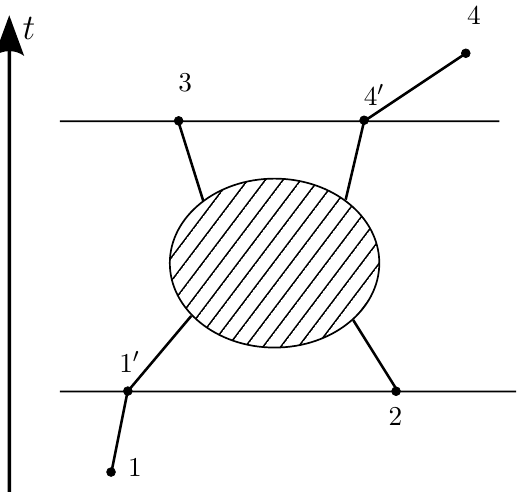
Figure 1 . Horizontal lines are t = t 3 and t = t 2 . The coordinates of the points 1 0 and 4 0 are ( t 0 = t 2 , x 0 ) and ( t 0 = t 3 , x 0 ) respectively. Both x 0 1 1 4 4